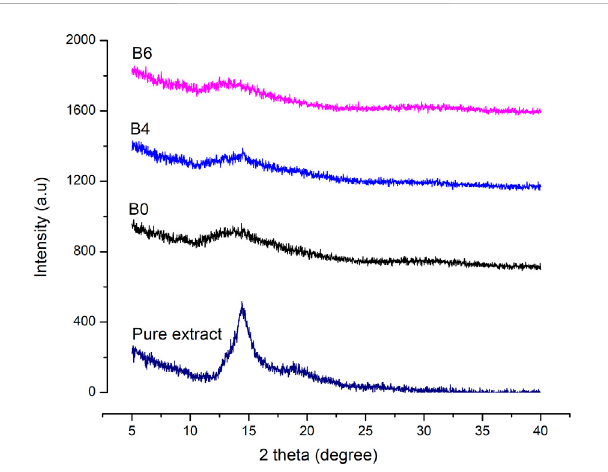
FIGURE 4 XRD graphsofpureBetulautilis extractandoptimizedformulations loaded with plant SEM